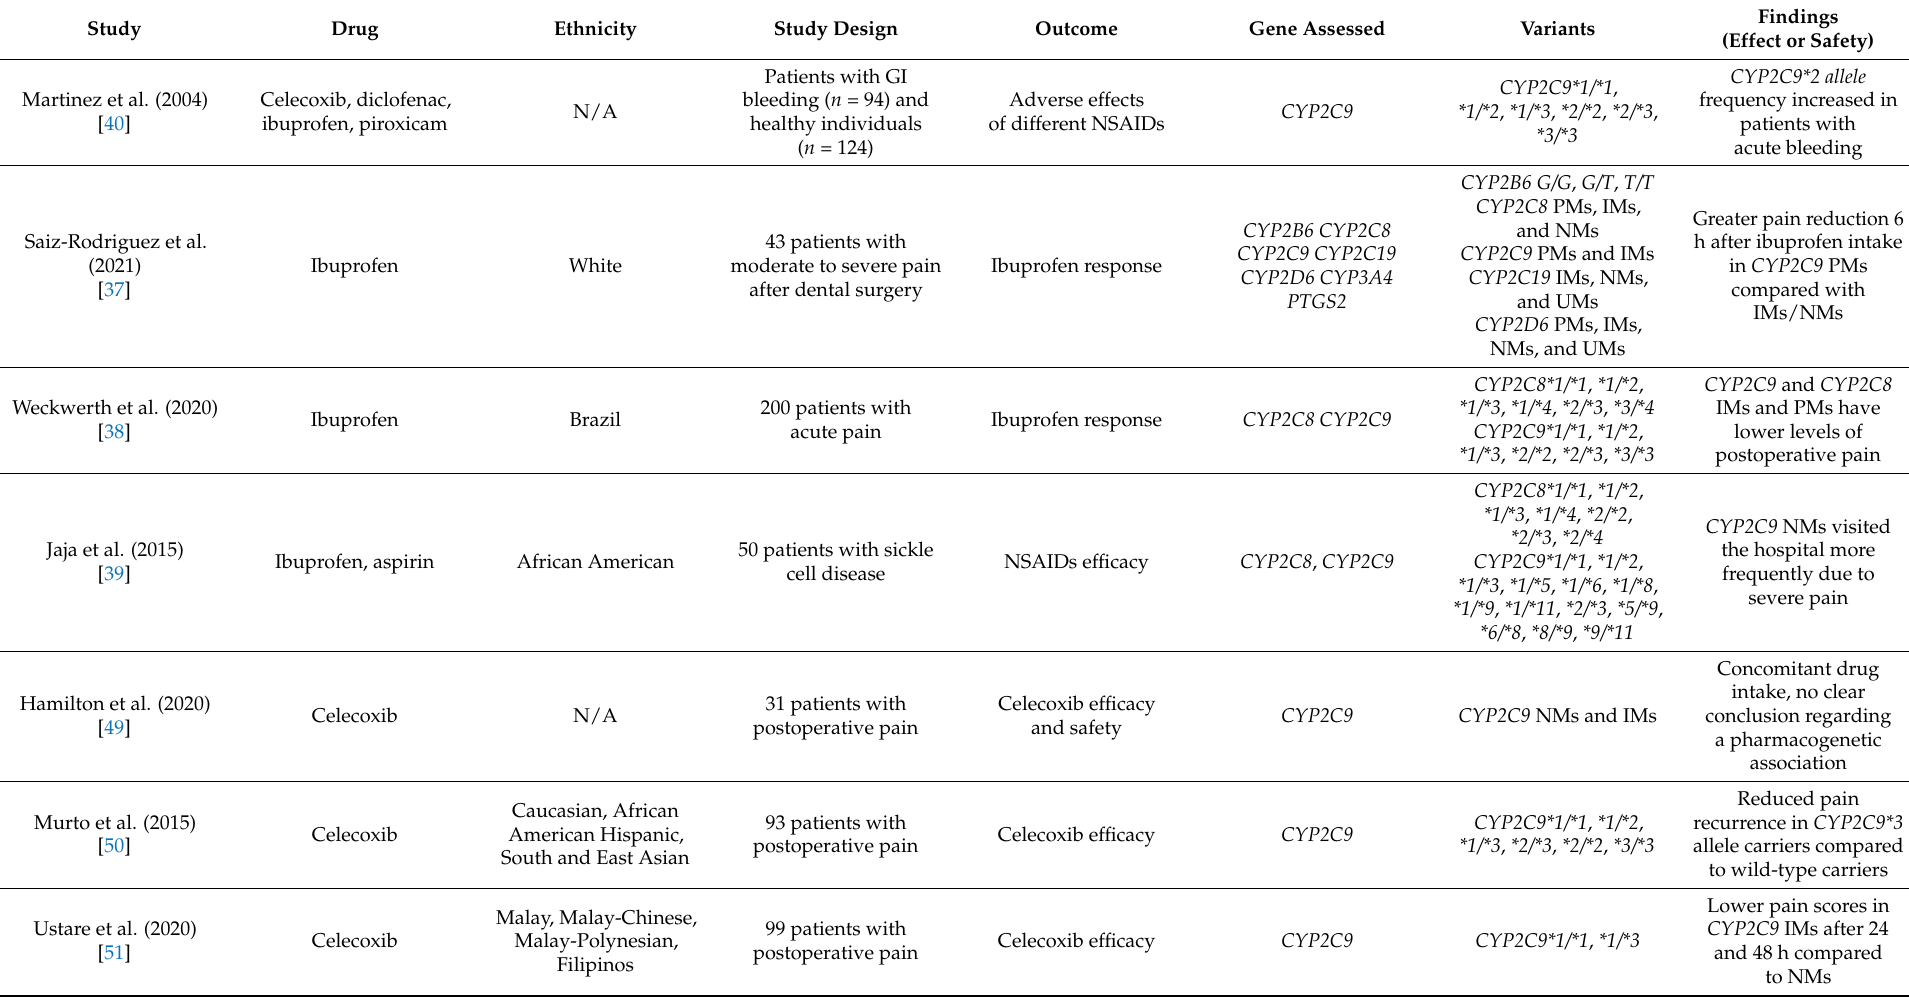
Table 2. Studies investigating the association between pharmacogenetics and the effect and safety of NSAIDs and aspirin in pain in vivo (human